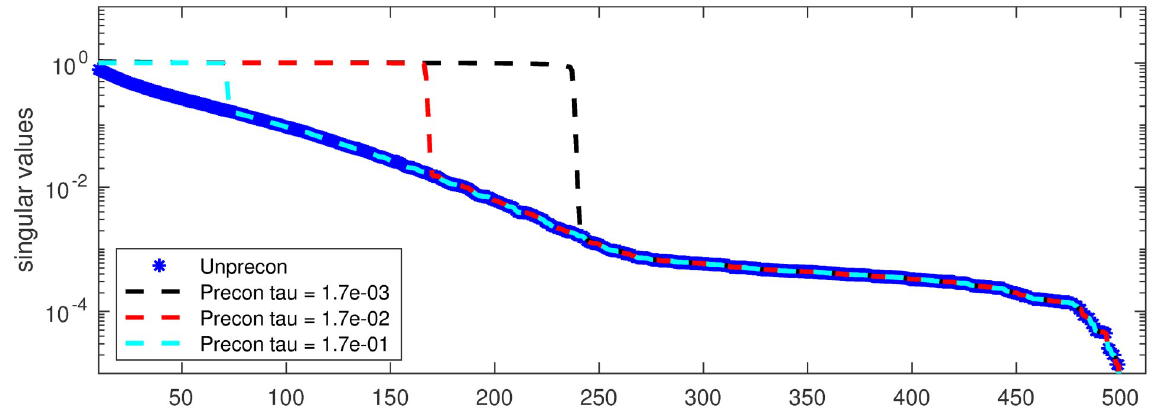
Fig 2. Spectrum of the unpreconditioned and preconditioned respirometry matrices for various choices of τ . Note the desirable clustering of the larger eigenvalues, which results in fast convergence of iterative methods.